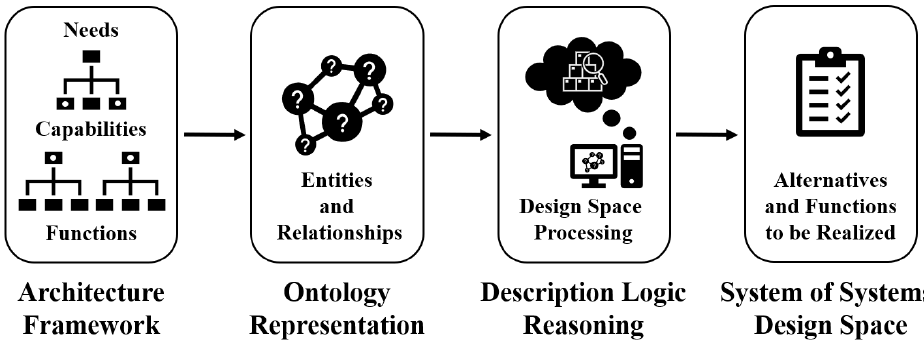
Figure 4. An illustration of the approach to breaking down SoS needs with an architecture framework and ontology to generate an SoS design